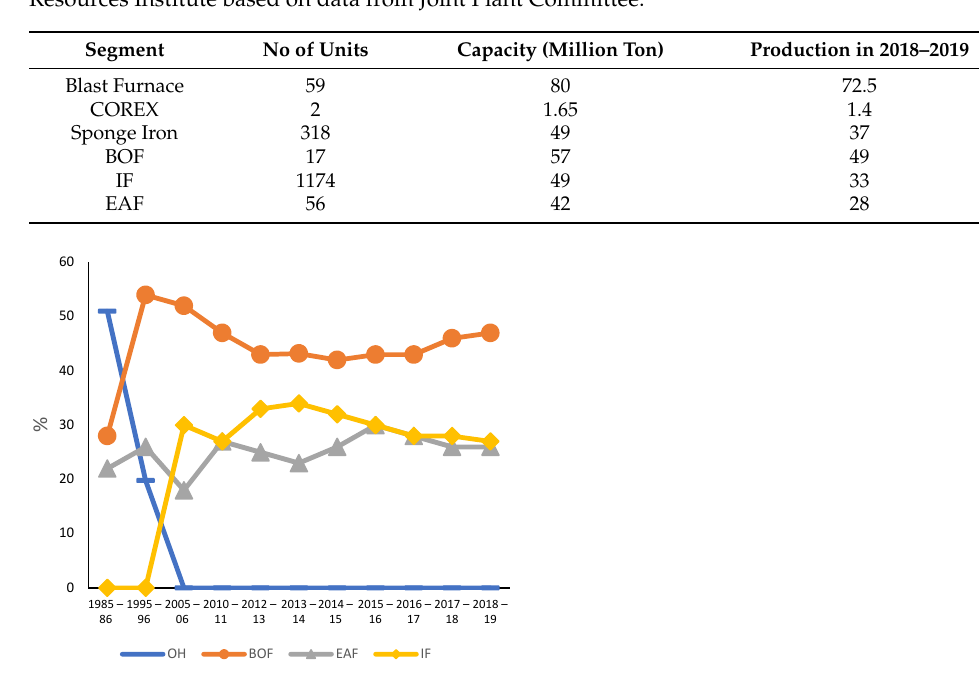
Figure 4. Crude steel production by process; share (%) OH—Open Hearth Process; BOF—Basic Oxygen Furnace; EAF—Electric Arc Furnace; IF—Induction Furnace. Graph plotted using data from India Brand Equity Foundation [4].